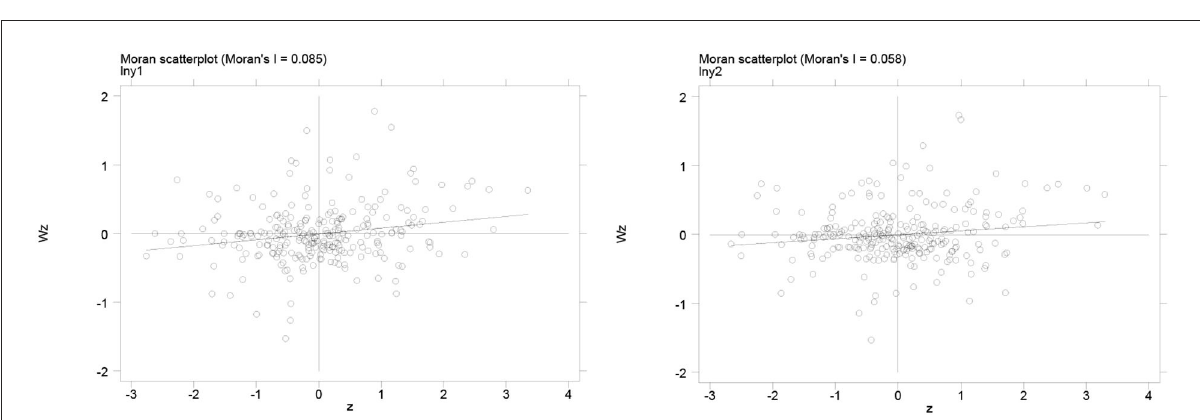
FIGURE3 Moran scatterplot of health care environment in 2010. The left graph denotes the Moran scatterplot of medical workforce (ln mw ) and the right graph denotes the Moran scatterplot of medical infrastructure (ln mi ).